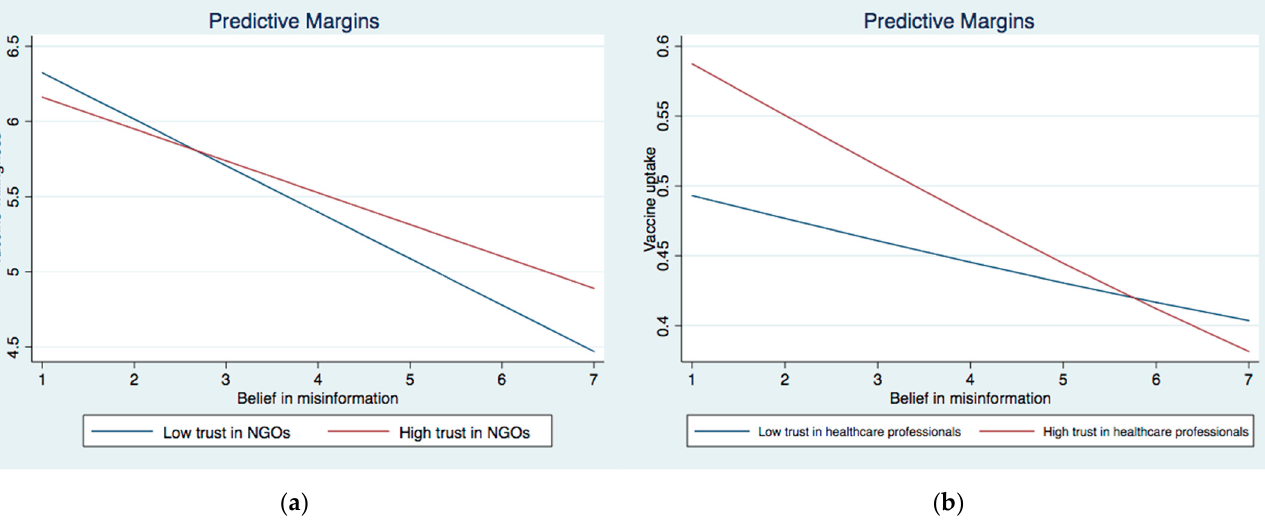
Figure 4. ( a ) Interaction between belief in misinformation and trust in NGOs on vaccine acceptance. ( b ) Interaction between belief in misinformation and trust in healthcare professionals on vaccine uptake.